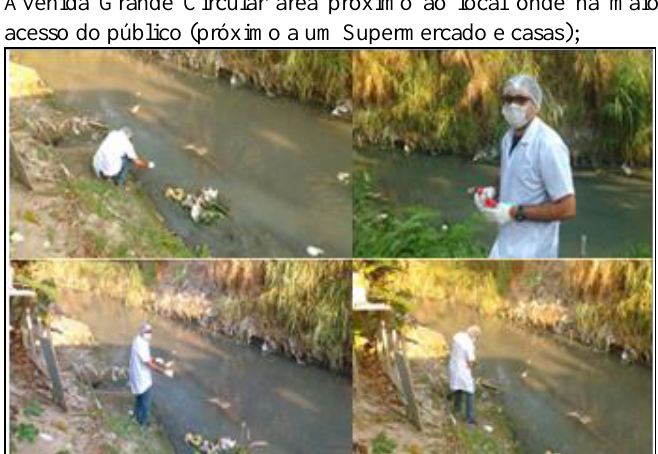
Figura 3: Igarapé do quarenta no bairro Armando Mendes. Fonte: Autores,